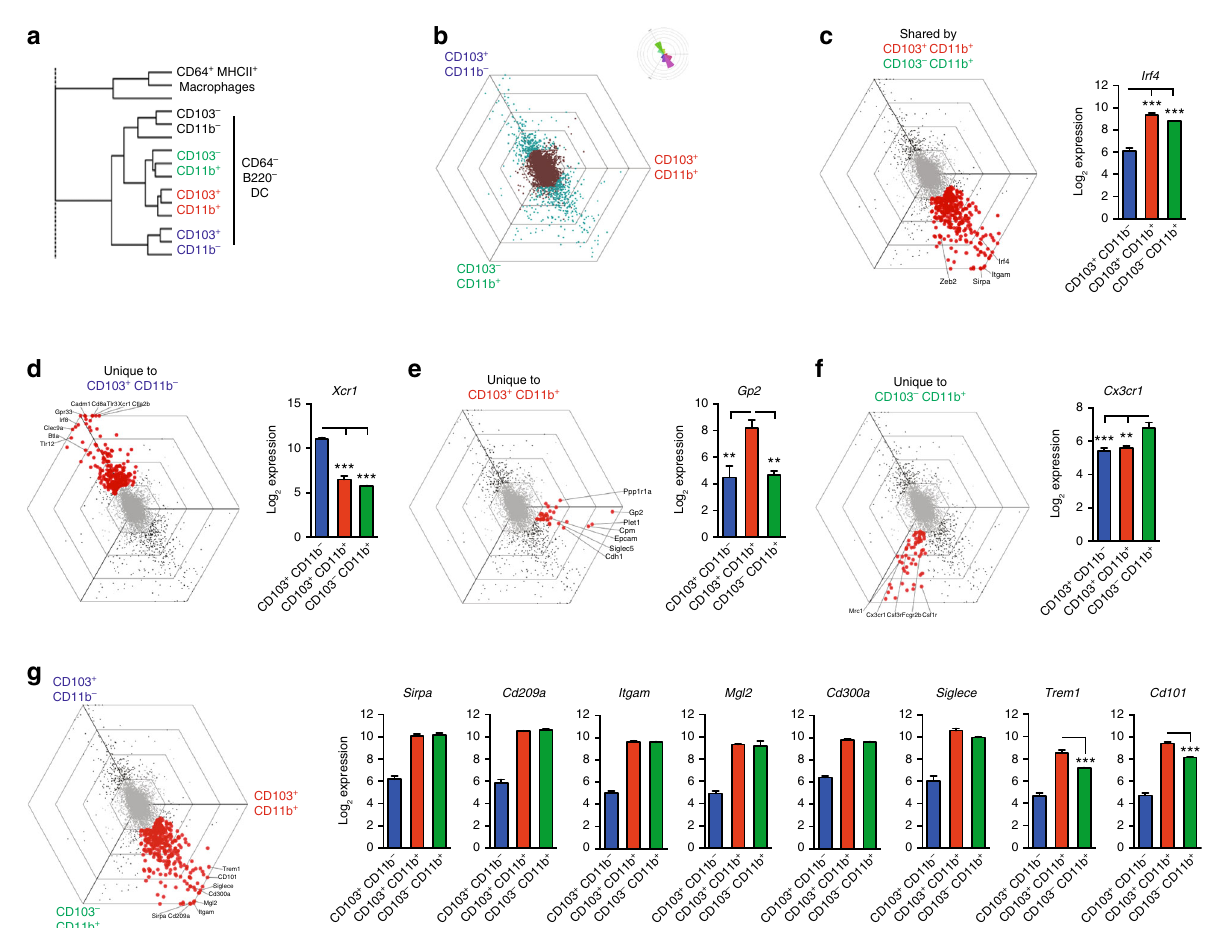
Fig. 5 Transcriptional pro fi ling of SILP DC reveals subset-speci fi c markers. a Hierarchical clustering of DC subsets and CD64 + MHCII + macrophages from the SILP of WT mice based on microarray pro fi les. b Hexagonal ‘ Triwise ’ plot displaying all arrayed genes with differentially expressed genes (adj. p -value < 0.01, logFC > 1 or < 1) depicted in cyan and non-differentially expressed genes shown in brown . Each grid line represents a log2 fold change. Rose plots show the percentage of genes falling in each vectorial direction. c Triwise plot highlighting genes differentially expressed (adj. p -value < 0.01, logFC > 1 or < 1) by CD103 + CD11b + DC and CD103 − CD11b + DC and not CD103 + CD11b − DC ( left ) and bar chart of Irf4 expression by DC subsets ( right ). Bars represent the mean + SEM Log 2 expression values of three biological replicates. d – f Triwise plots highlighting genes differentially expressed (adj. p -value 0.01, LogFC > 1 or < 1) by CD103 + CD11b − DC d , CD103 + CD11b + DC e and CD103 − CD11b + DC f ( left panels ) and mean + SEM Log 2 expression values of Xcr1 , Gp2 and Cx3cr1 by DC subsets ( right panels ). g Triwise plots depicting the genes that are most differentially expressed by CD103 + CD11b + and CD103 − CD11b + DC subsets compared with CD103 + CD11b − DC ( left ); mean + SEM Log 2 expression values of these genes ( right region between the CD103 + CD11b + and CD103 − CD11b + axes). This generated an additional 34 genes (Fig. 5g and Supplementary Table 6), of which 18 encoded cell surface markers (Supplemen-